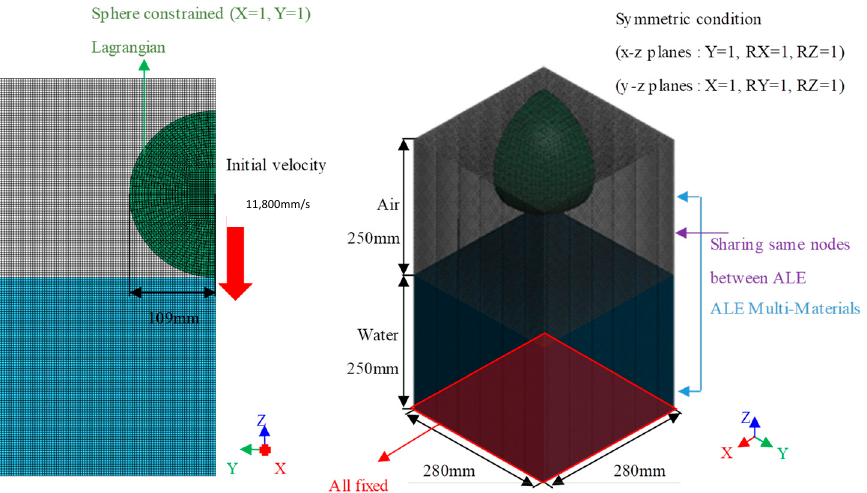
Figure 4. FE model for the air-water-dropping sphere.